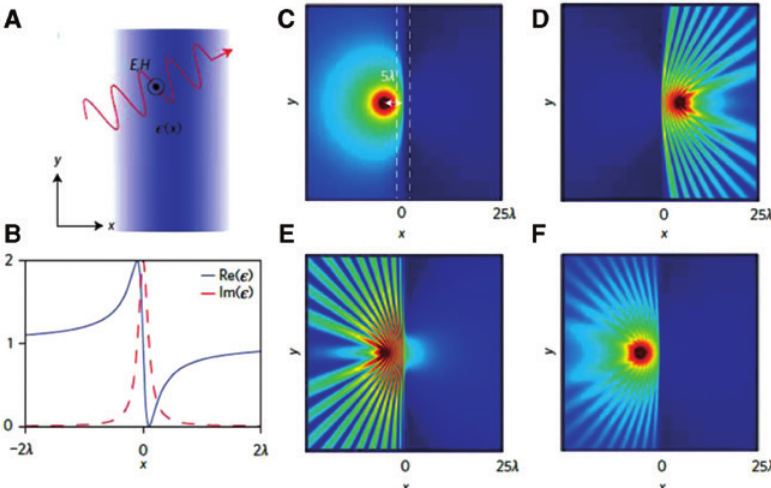
Figure 7: Unidirectional reflectionlessness of a planar inhomogeneous dielectric structure in which the spatial distributions of the real and imaginary parts of the dielectric permittivity are related by Kramers-Kronig relations. (A) A wave propagating in the x – y plane in an inhomogeneous medium with permittivity ε (x) (indicated by blue shading). The TE polariza- tion has an electric field pointing only along z and the TM polarization has a magnetic field pointing only along z . When the real (blue) and imaginary (red) parts of the permittivity are related to one another by the Kramers-Kronig relations (as in B), then the reflection vanishes for all angles of incidence. (B) Permittivity profile ε ( x ) given by Equation (7) for parameters A = 2 and ξ = 0.1 λ with λ = 2 π / k values of the electric field of a line source placed at positions x = −5 λ (C) and x = + 5 λ (D) in the permittivity profile. The region between the vertical dashed lines in (C) indicates the region plotted in (B). (E and F) As in (C and D), with identical parameters, but taking only the real (E) and imaginary (F) parts of the permittivity. The absence of any oscillations in (C) shows that the reflection is completely suppressed for incidence from the left for all incident angles